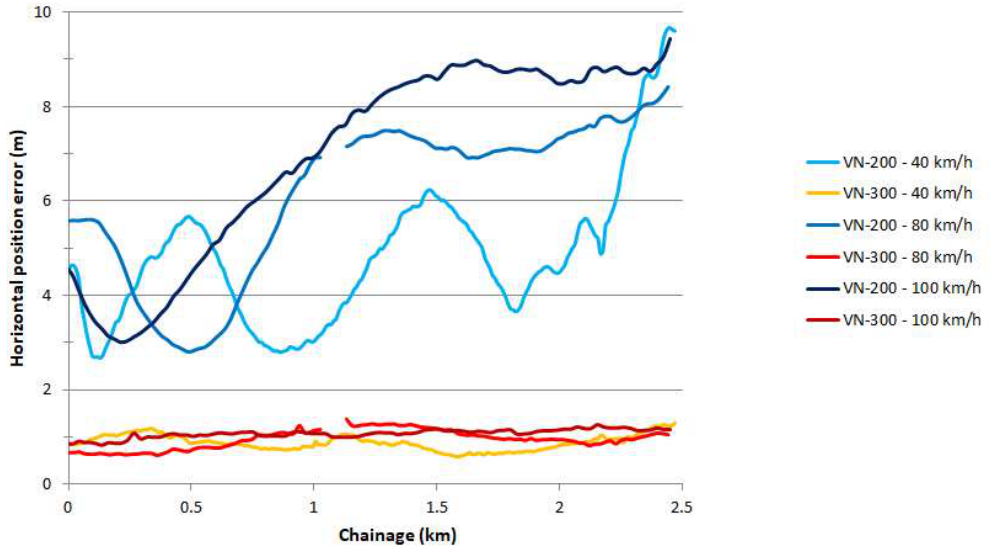
Figure 8. Variability in the two-dimensional (2D) position errors recorded by the VN-200 and VN-300 devices as a function of the route length when travelling at speeds of 40 km/h, 80 km/h and 100 km/h along section no. 4.